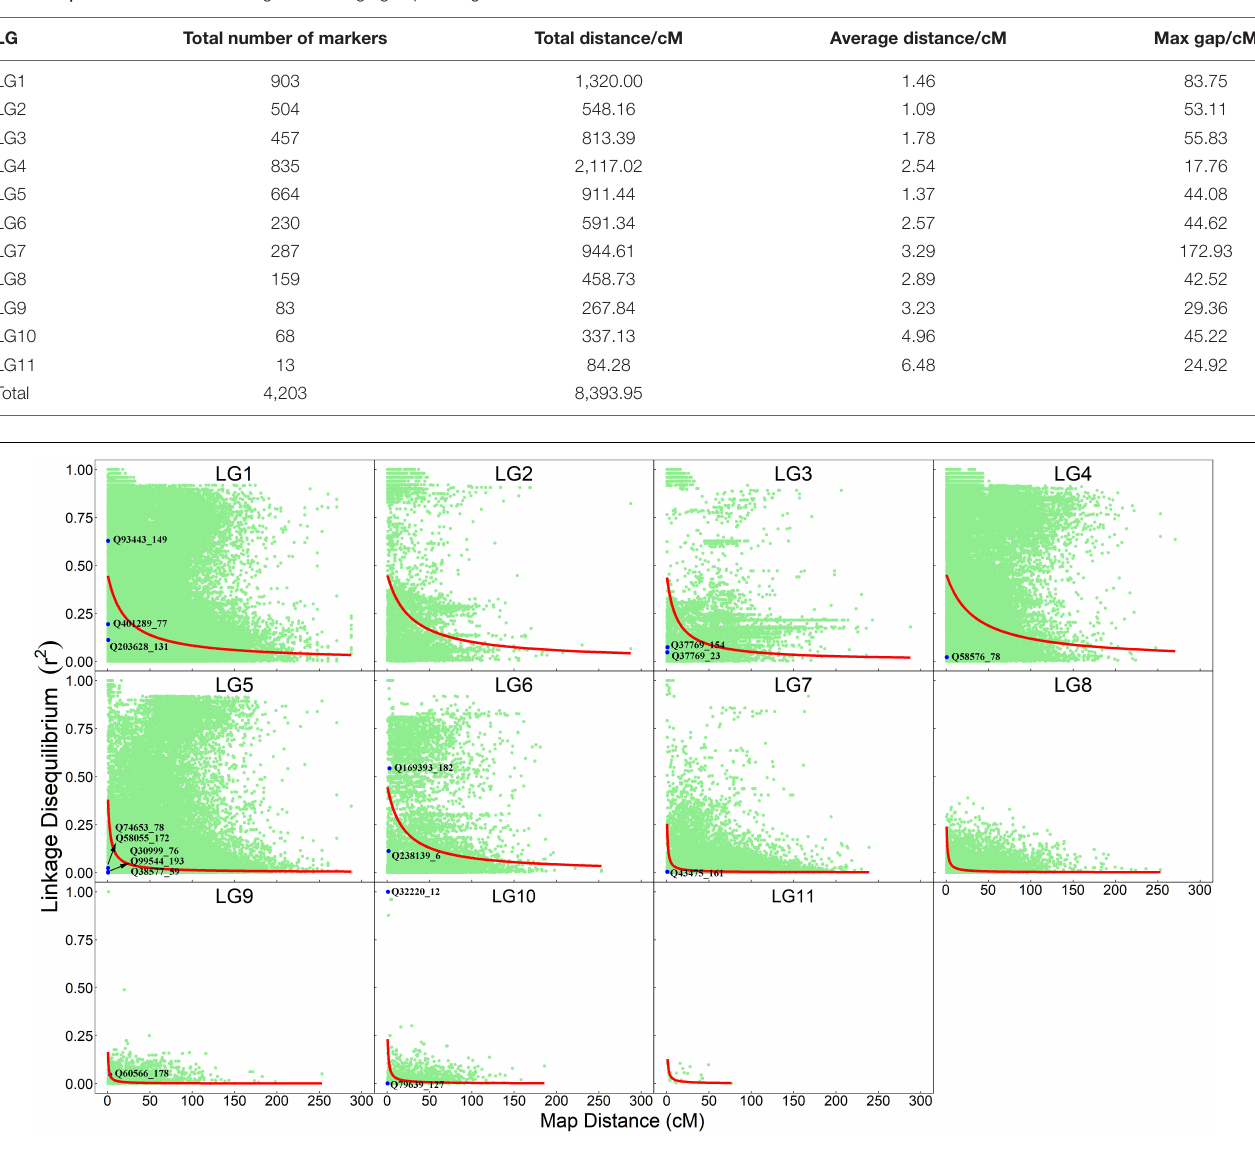
FIGURE 2 | Linkage-linkage disequilibrium map expressed as a plot of normalized LD values against map distance for marker pairs from the same linkage groups. Red line denotes the decay curve of LD with increasing genetic distance. QTLs that are detected to affect seedling growth traits are